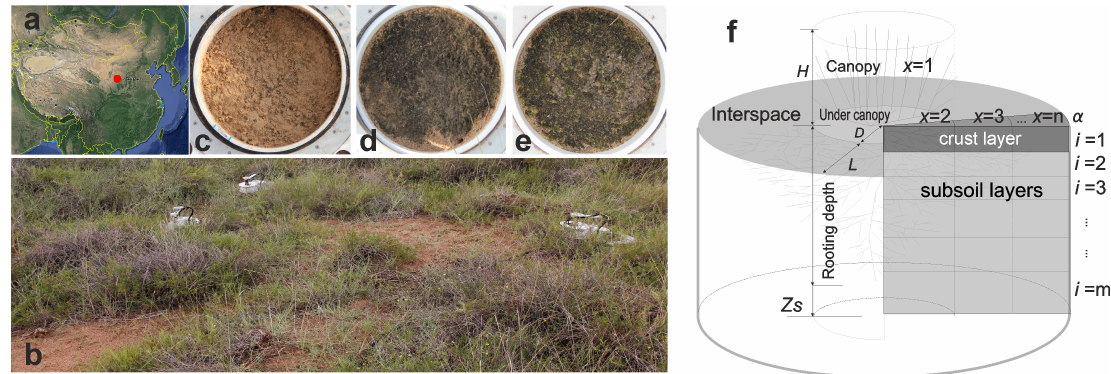
Figure 1. Site position (a) , overlook of measured ecosystem (b) , appearance of soil surface at collar C1 (c) , C2 (d) and C3 (e) , and layout of representative land unit (RLU, adopted from Gong et al., 2016) (f) .